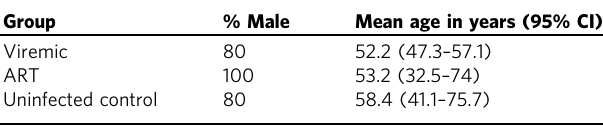
ART antiretroviral therapy, CI con fi dence